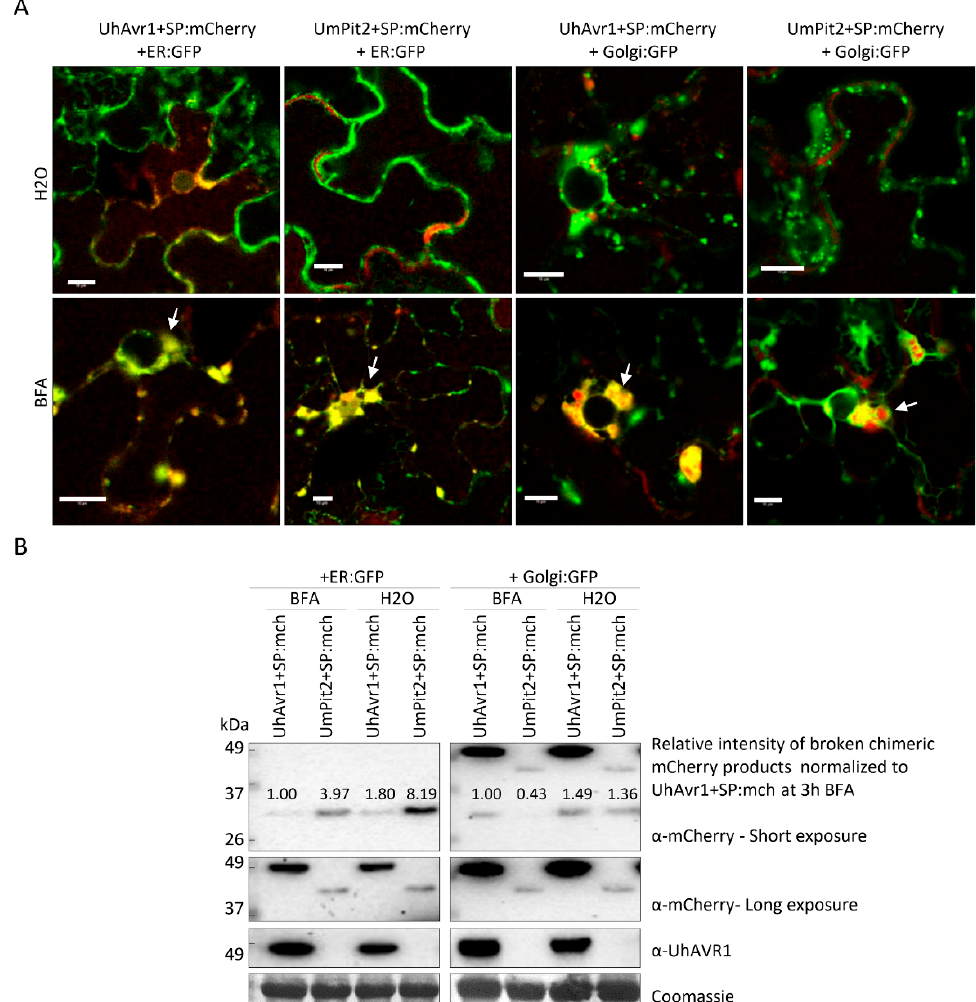
Figure 9. UhAVR1:mCherry and UmPit2:mCherry co-localize with fused ER–Golgi in N. benthamiana leaf cells upon BFA exposure. ( A ) Confocal microscopy of mCherry-tagged fungal e ff ectors which accumulate in secretory pathway organelles of N. benthamiana leaf cells upon BFA exposure. A. GFP-tagged ER or Golgi organelle marker were co-agroinfiltrated with UhAvr1 + SP:mCherry or UmPit2 + SP:mCherry and exposed to BFA or water. mCherry fluorescence from both chimeric e ff ectors (arrows) co-localized with the fused ER–Golgi (GFP fluorescence) after 4 h of BFA exposure. UmPit2:mCherry and UhAVR1:mCherry fluorescence localized to the apoplast and cytosol, respectively, upon water exposure. Snapshots of a single optical section are displayed, and the scale bar represents 10 µ m. ( B ) Protein blot analyses from the same batch of plants used in panel A showed the SP-cleaved UhAVR1:mCherry (predicted size of 46 kDa) and UmPit2:mCherry (predicted size of 37 kDa) after 3 h of BFA or water exposure. Breakdown products were detected only with anti-mCherry antibody. Immuno-blots were imaged for shorter or longer exposure to reveal unsaturated mCherry breakdown products and the full-length proteins. The intensity value of each breakdown chimeric mCherry product was calculated by Image Lab software and provided on the gel picture. Short exposure of blots probed with anti-mCherry antibody corresponds to 16 s for the + ER:GFP and 2002 s for + Golgi:GFP. Whereas, long exposure of the same blots corresponds to 4429 s for + ER:GFP and 2541 s for + Golgi:GFP. Three independent repeats were done and a representative image is shown.